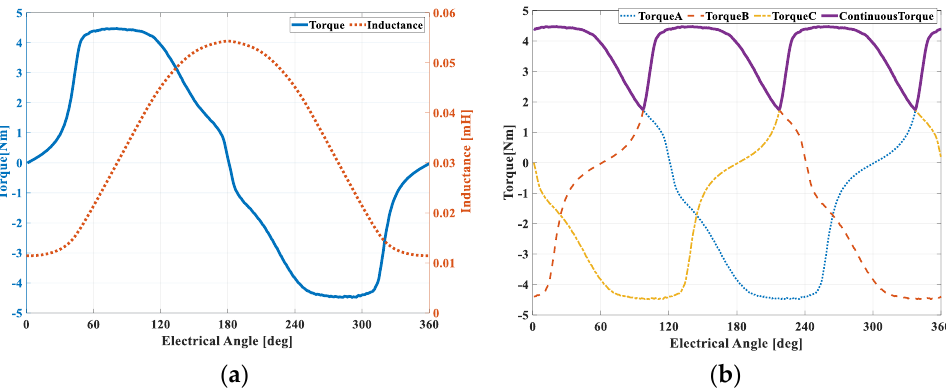
Figure 11. Inductance profile and torque of the initial model: ( a ) Static torque and inductance, ( b ) Continuous torque. Figure 12a,b show the static torque and inductance profile, and continuous torque of the final optimized model, respectively. The average torque and torque ripple of the opti- mized model are 4.35 [Nm] and 73%, respectively. The maximum to minimum inductance ratio of the initial and final optimized models are 4.5 and 6.1, respectively.